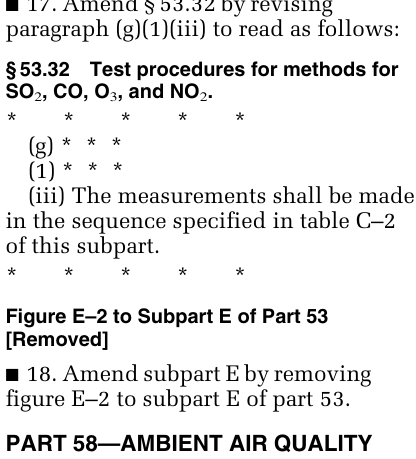
figure E–2 to subpart E of part